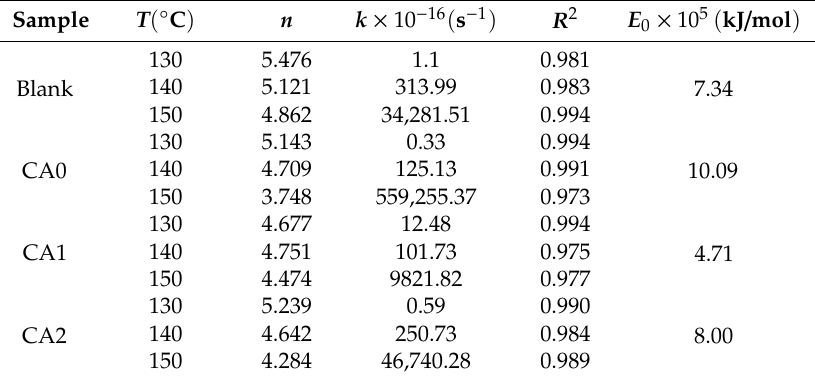
Table 2. Kinetic parameters for the curing reactions in the composite NR compound in various NR-g-St loadings and measurement